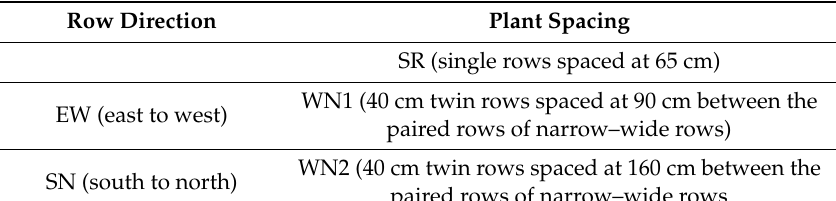
Table 1. The experiment design.